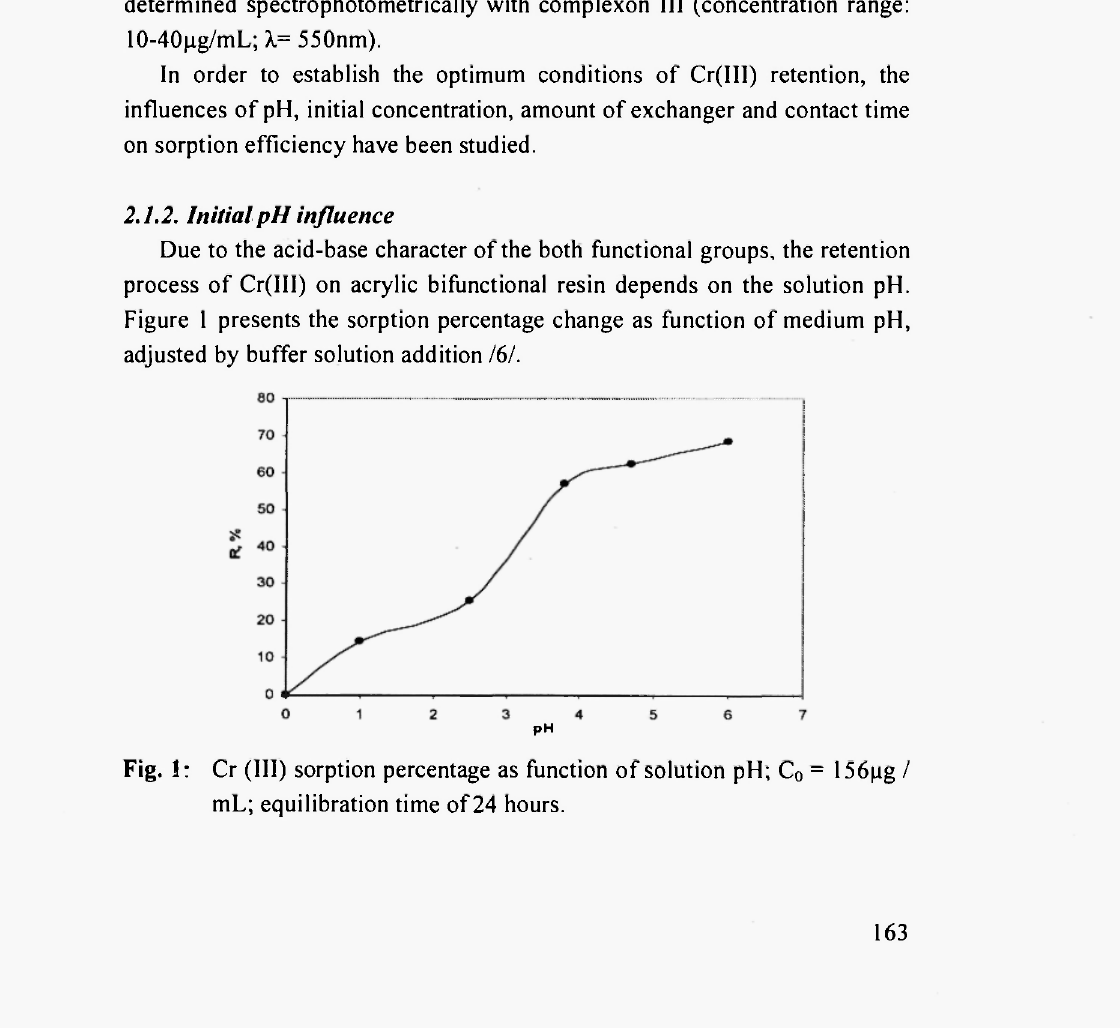
Fig. 1: Cr (III) sorption percentage as function of solution pH; C 0 = 156μg / mL; equilibration time of 24